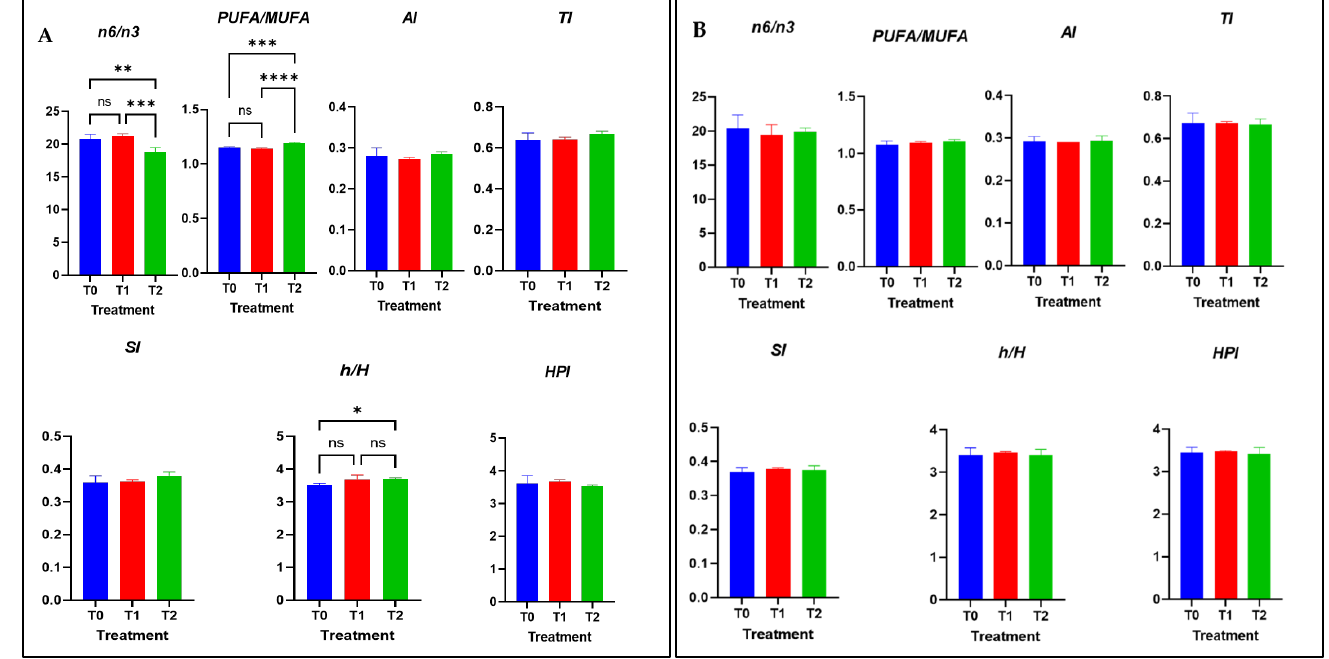
Figure 1. Treatment effects on nutritional quality indices of the lipids in breast ( A ) and thigh meat ( B ) The main effects of diet are presented in each graph (Prism Graph 9.03). Data are presented as mean SEM (n = 6 broilers/group). Asterisks denote statistical significance ( p > 0.1234 ns, * p ≤ 0.0332, ** p ≤ 0.0021, *** p ≤ 0.0002, **** p < 0.0001); T0: control diet; T1: treatment with 0.00002% Cr; T2: experimental diet supplemented with 0.00002% Cr +2% sea buckthorn leaves (SBL); AI = atherogenic index; TI = Thrombogenicity index; SI= saturation index; h/H = Hypo/hypercholesterolemic index; and HPI = health-promoting index . ns= non-significant.